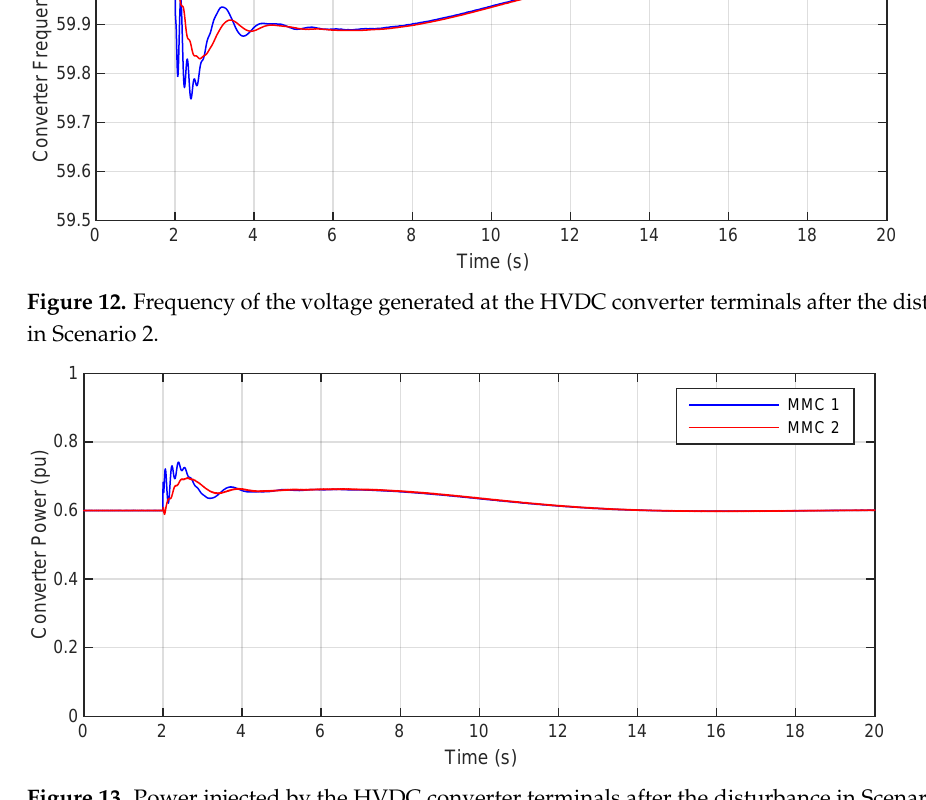
Figure 13. Power injected by the HVDC converter terminals after the disturbance in Scenario